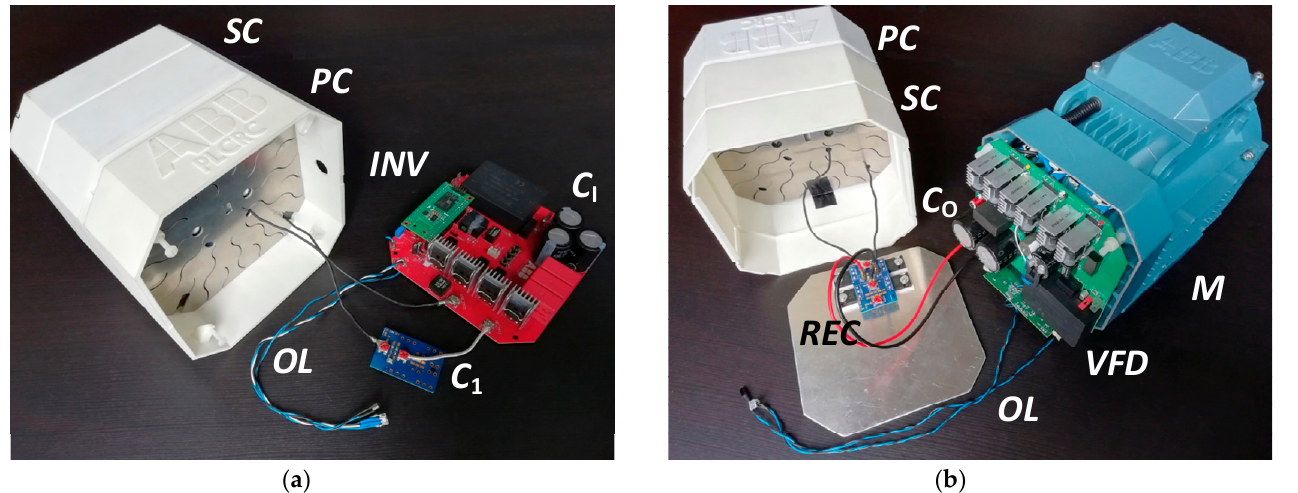
Table 2. Parameters of IPT-IMD system.